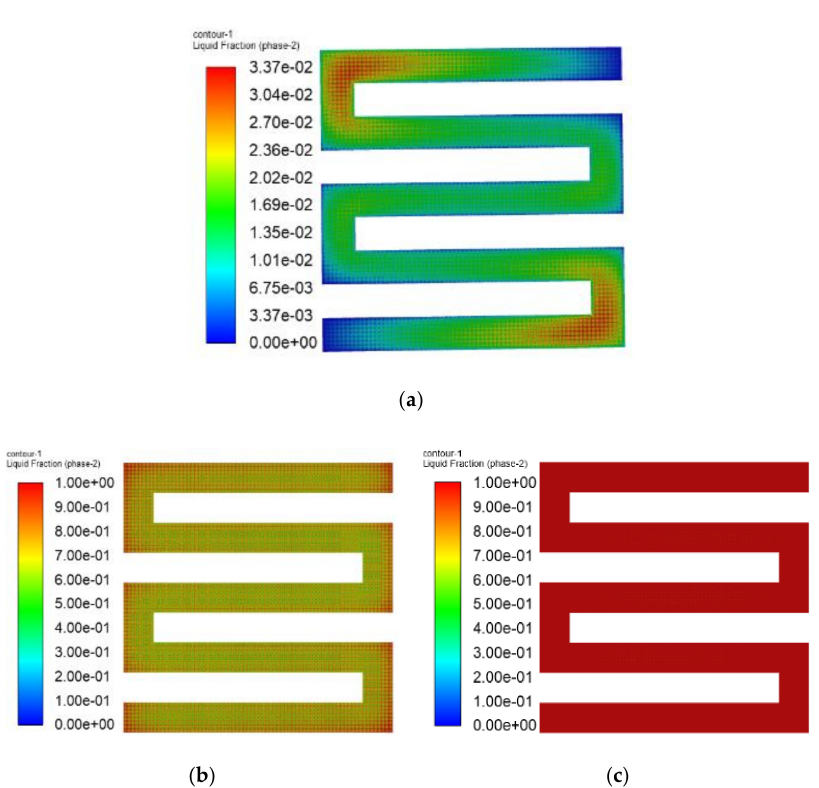
Figure 27. The fuel cell temperature contours with pore diameter = 0.3 mm at di ff erent times; ( a ) t = 28 s, ( b ) t = 40 s, ( c ) t = 44 s.